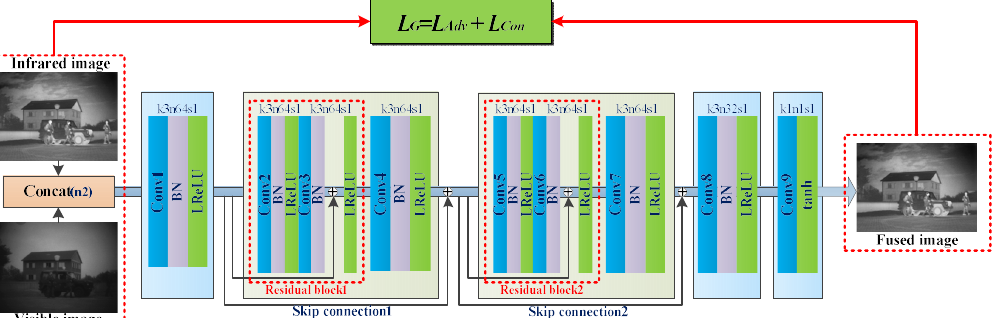
Figure 4. The network structure of the generator.